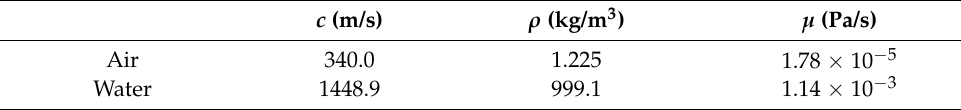
Figure 6. Geometry of ( a ) expansion chamber and ( b ) model-scale scrubber; dimensions in mm.